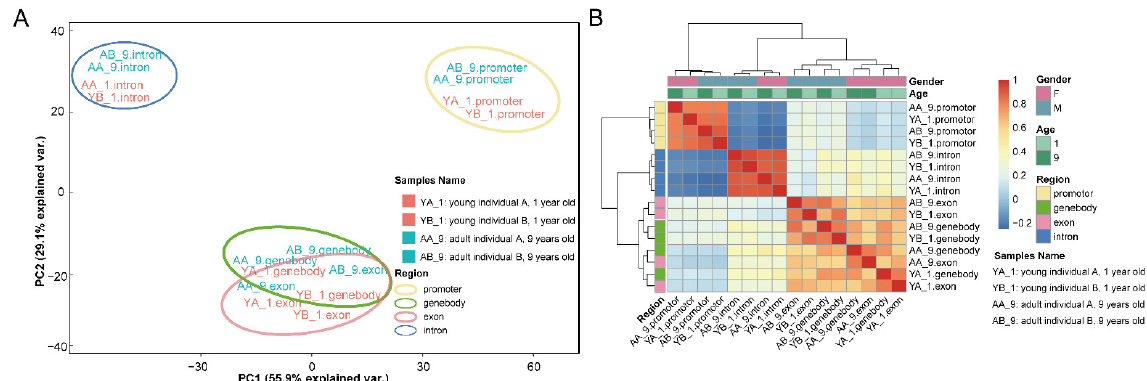
Figure 1. PCA and Spearman’s correlation analyses of four individuals based on the DNA methyl- ation levels of the genomic regions (promoter, gene body, exon and intron). ( A ) PCA analysis of 29,324 autosomal genes. ( B ) Heatmap of Spearman’s correlation analyses of 29,324 autosomal